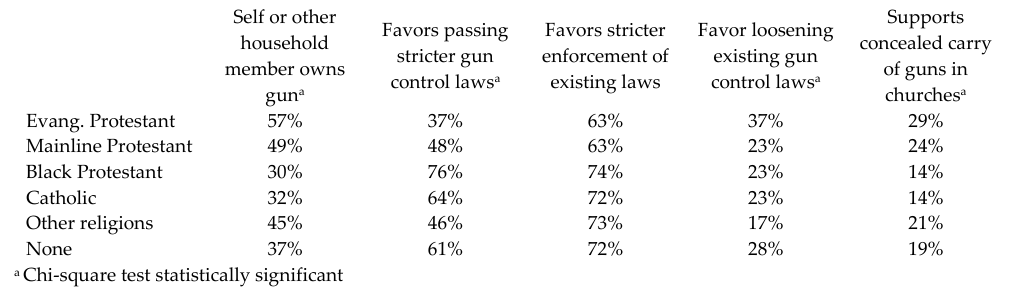
Table 2. Gun ownership and support for gun control by religious tradition.